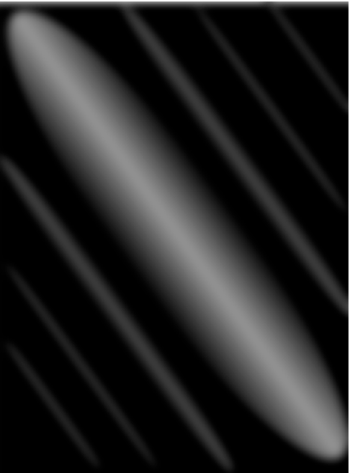
Figure 6. The quotient of the 2D Fourier’s transformed for two consecutive frames.